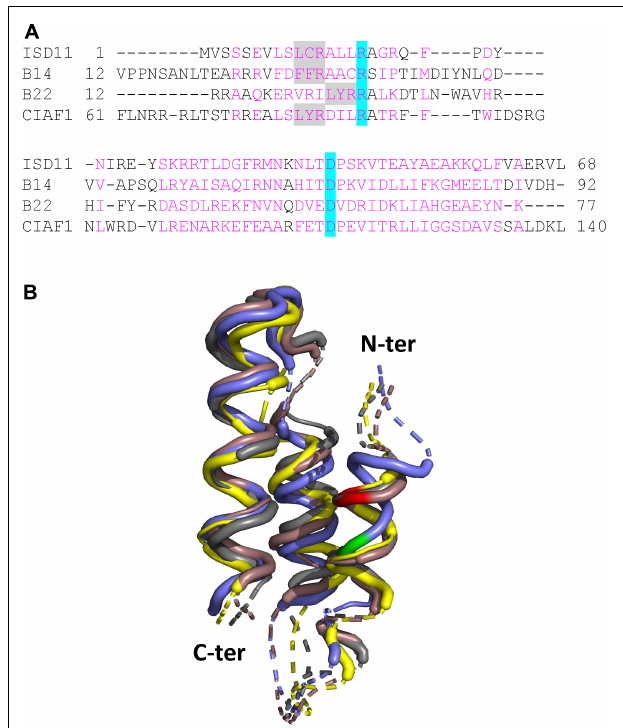
FIGURE 2 | LYRM proteins associated with complex I in plants. (A) Structure-based sequence alignment. The alignment was generated with mTM-align (Dong et al., 2018) and manually adjusted to focus on the LYRM common core regions (amino acids are numbered on both sides). We used the structures of the B14 and B22 subunits present in the Brassica oleracea complex I cryo-EM structure (Soufari et al., 2020) and structural models of Arabidopsis ISD11 and CIAF1 generated by alphafold (Jumper et al., 2021). Amino acids in magenta correspond to common core regions. The only two conserved residues are highlighted in blue; the LYR motif in gray. Noteworthy, in the B14 protein the FFR motif is degenerated, and the conserved Arginine (R) is not even present in some algal sequences. (B) 3D structure superimposition of the core helices. The superimposed structure file in common core regions generated by mTM-align was visualized with Pymol. The ISD11, B14, CIAF1, and B22 proteins are represented in brown, yellow, gray and violet, respectively. Dashed lines represent variable spacing regions. The LYR motif in ISD11, B14, CIAF1 is colored in red, whereas for the B22 protein it is in green and shifted by one helix